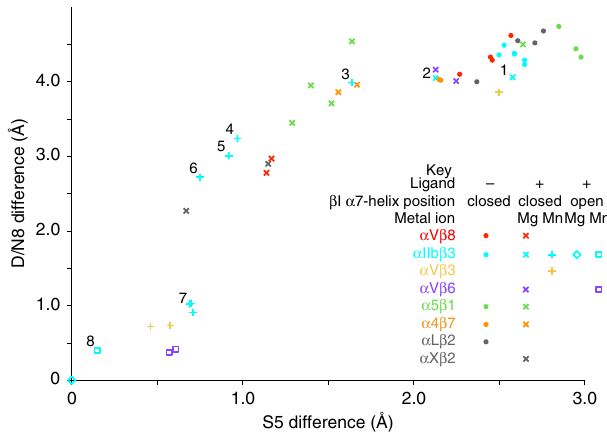
Fig. 4 Measurements from crystal structures of the relative positions of β -MIDAS S5 and D/N8 residues. Distances from an open conformation structure (integrin α IIb β 3, PDB code 2VDR) of β -MIDAS S5 and D/N8 residues in liganded and unliganded integrin structures. Measurements show C α atom — C α atom distances. Numbers mark closed (1), open (8), and intermediate (2 – 7) ligand-bound states de fi ned in a study in which ligand was soaked at different concentrations in Mg 2 + or Mn 2 + into crystals containing two independent copies of the closed α IIb β 3 headpiece 21 . Crystal structures with missing β I domain metals or lacking deposited structure factors were not plotted. Representative β I domains from each integrin β -subunit were superimposed with Deep Align 36 . Each independent molecule in asymmetric units was then superimposed on the cognate β -subunit and distances were measured with PyMol to one-hundredth Å. The PDB code and chain ID of the plotted structure models listed as PDB/ Chain ID in order of increasing S5 difference are 2VDR/B, 3ZE2/D, 4MMY/ B, 5FF0/F, 4MMX/B, 5FF0/B, 4NEH/B, 3ZE0/B, 3ZE1/B, 3ZDZ/B, 3ZE2/B, 3ZE1/D, 3ZE0/D, 6OM2/B, 4NEN/B, 6OM2/D, 4WK4/B, 3VI4/B,